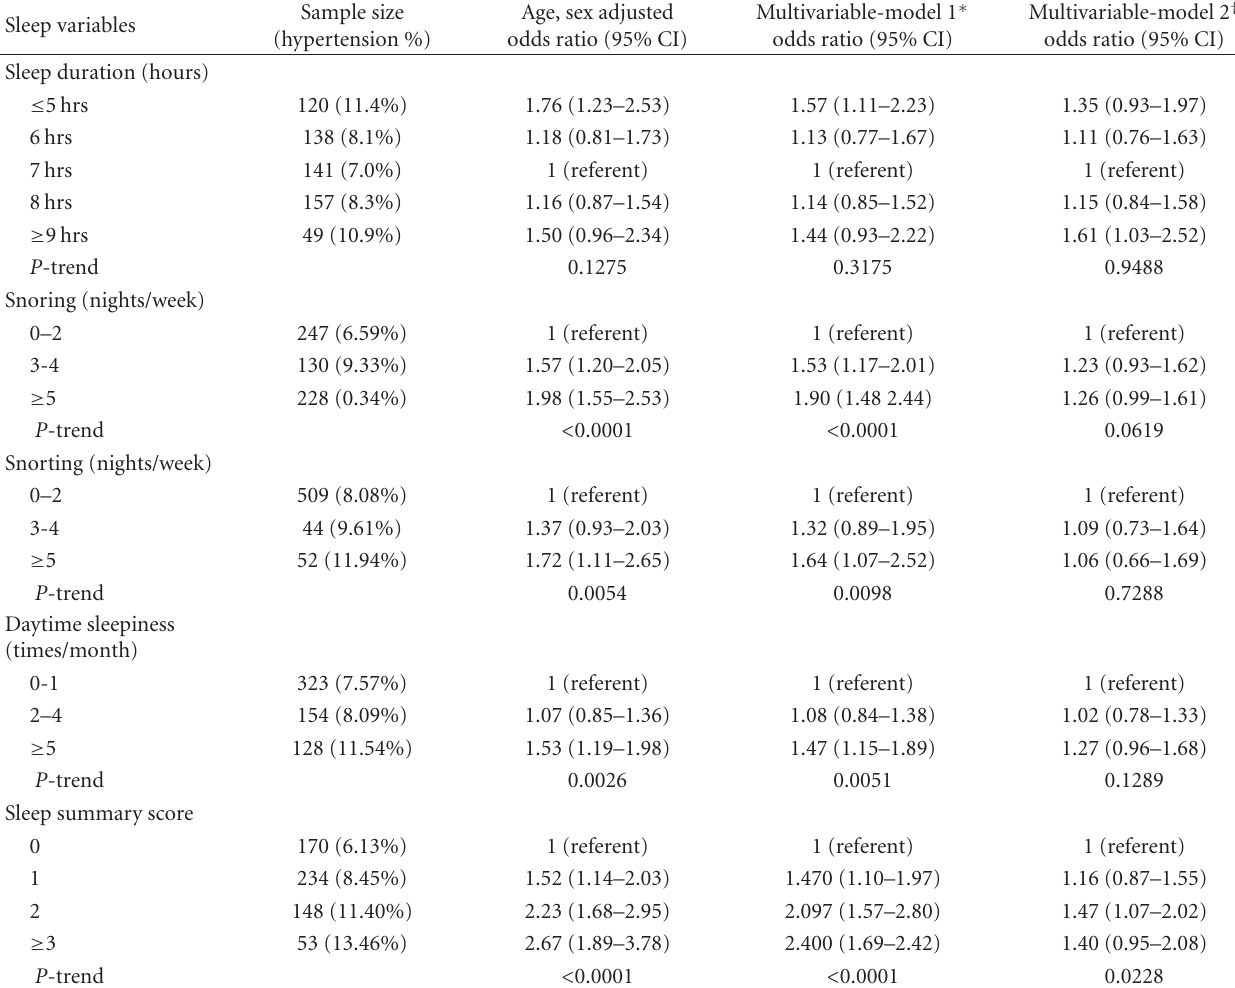
Table 2: Association between sleep-disordered breathing variables and C-reactive protein levels > 1mg/dL.